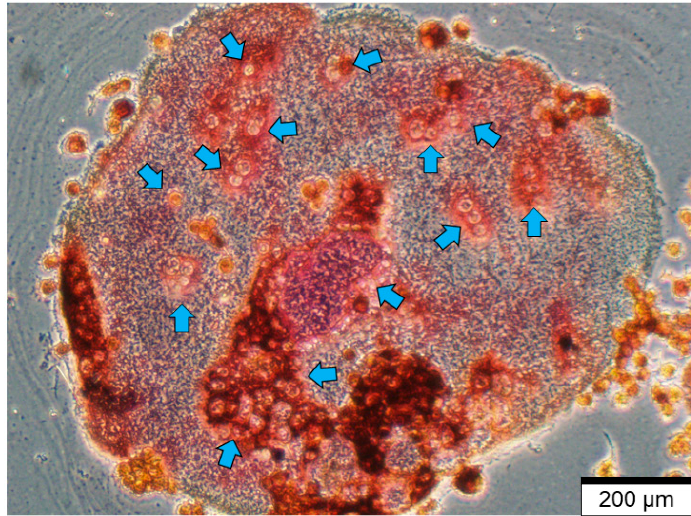
Figure 3. Mature, multi-nucleated osteoclast in vitro. Pictured is one mature osteoclast differentiated with exogenous RANKL. The osteoclast has multiple nuclei (blue arrows) and stained tartrate resistant acid phosphatase (TRAP) positive, indicative of a mature osteoclast. (pink-brown stain). Scale = 200 μ m.